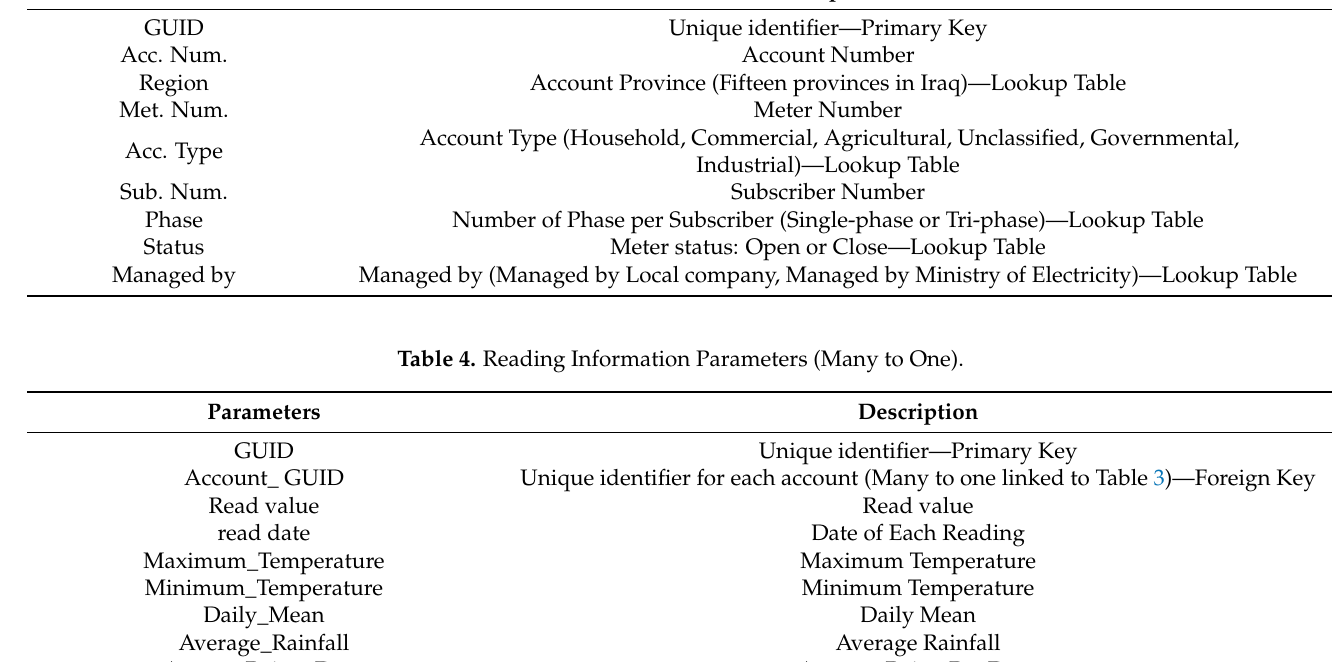
Table 3. Account information parameters.